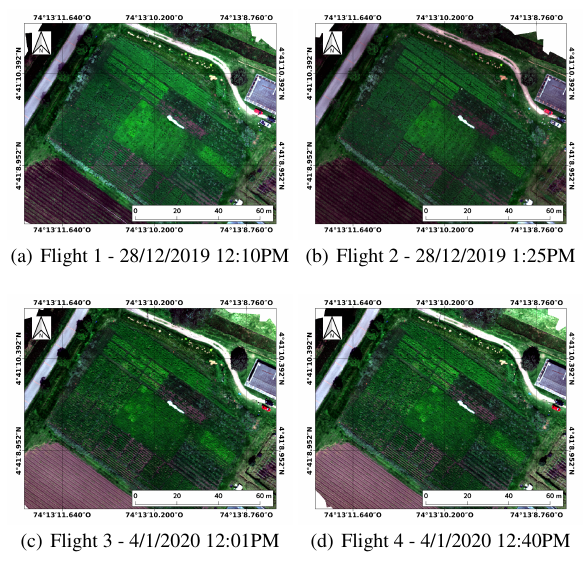
Figure 11. Results - DEM